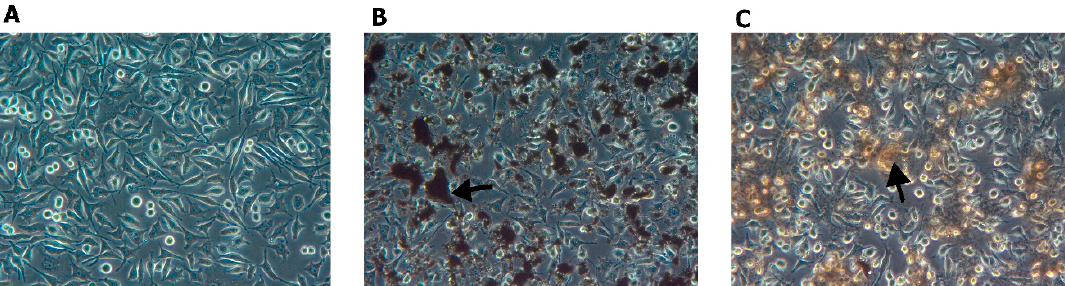
Figure 12. Morphology of HS-5 cells treated with PG and GO. ( A ) Control group; ( B ) PG group; ( C ) GO group. Black arrows indicate graphene and graphene oxide agglomerates.